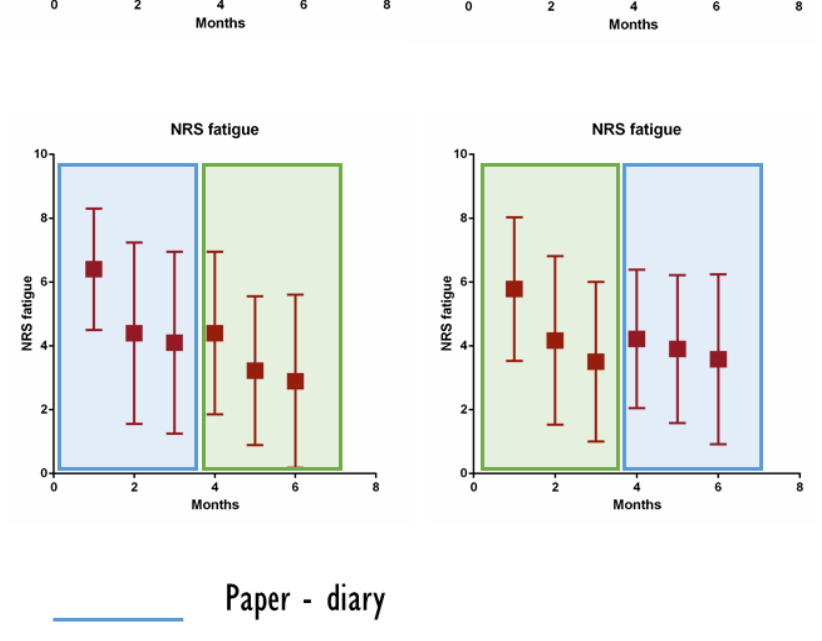
Figure 4. Decrease in NRS perceived activity, pain and fatigue in the PD and TuTOR app groups. 3.3. HAQ